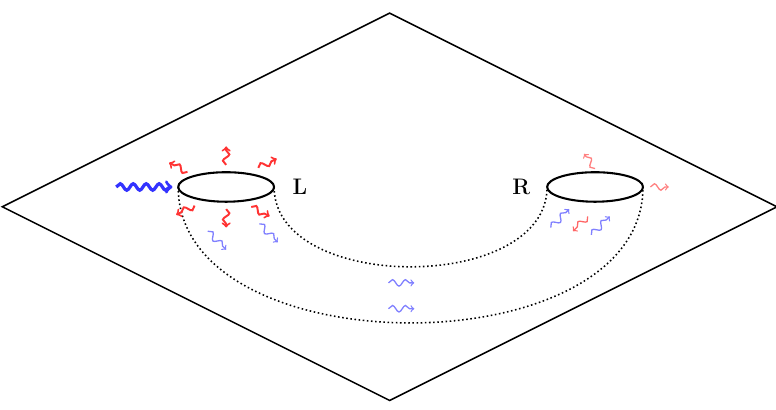
Figure 5 . We draw 4d eternal traversable wormhole connecting two magnetically charged holes. In the scattering problem, the incident wave is absorbed into one end of the wormhole, traveling to the other side. In the other side, there may be re(cid:13)ected wave as well as transmitted wave to the asymptotic region in general. In this sense, the relevant scattering problem is